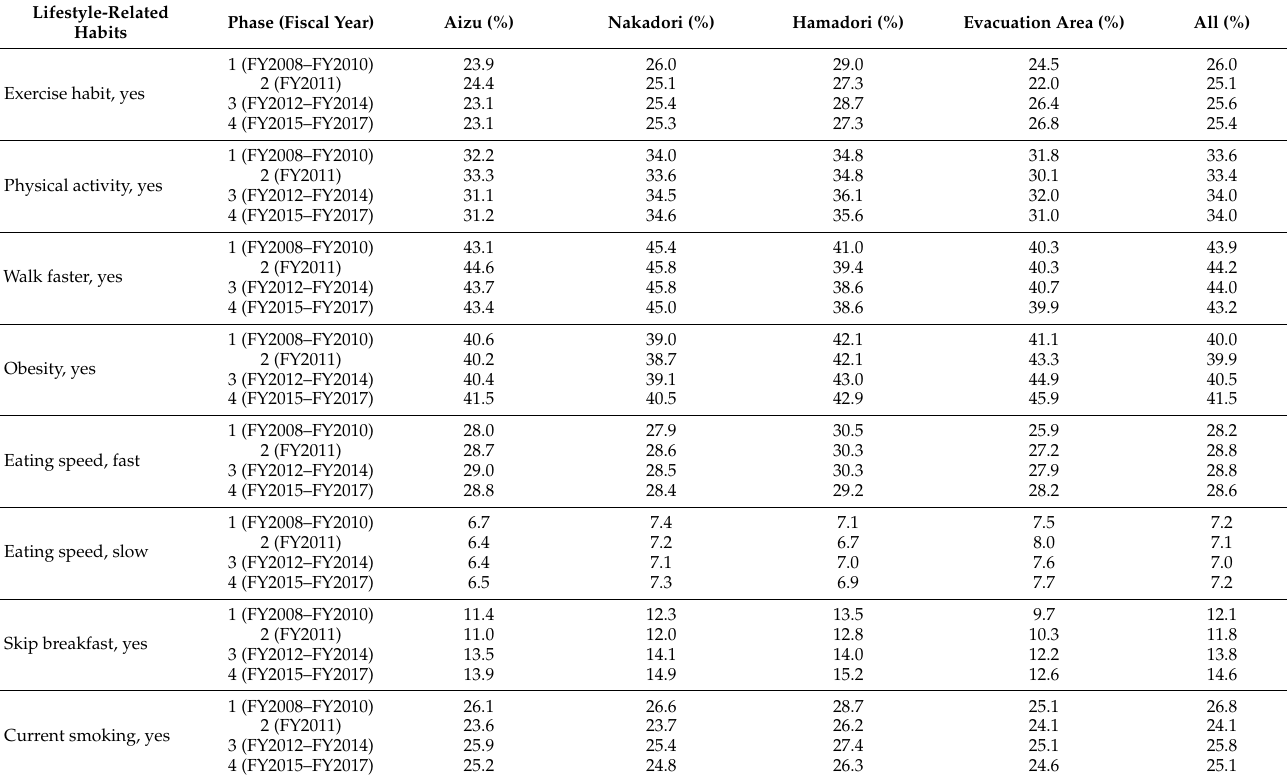
Table 3. Regional differences in the proportion of lifestyle-related habits in each